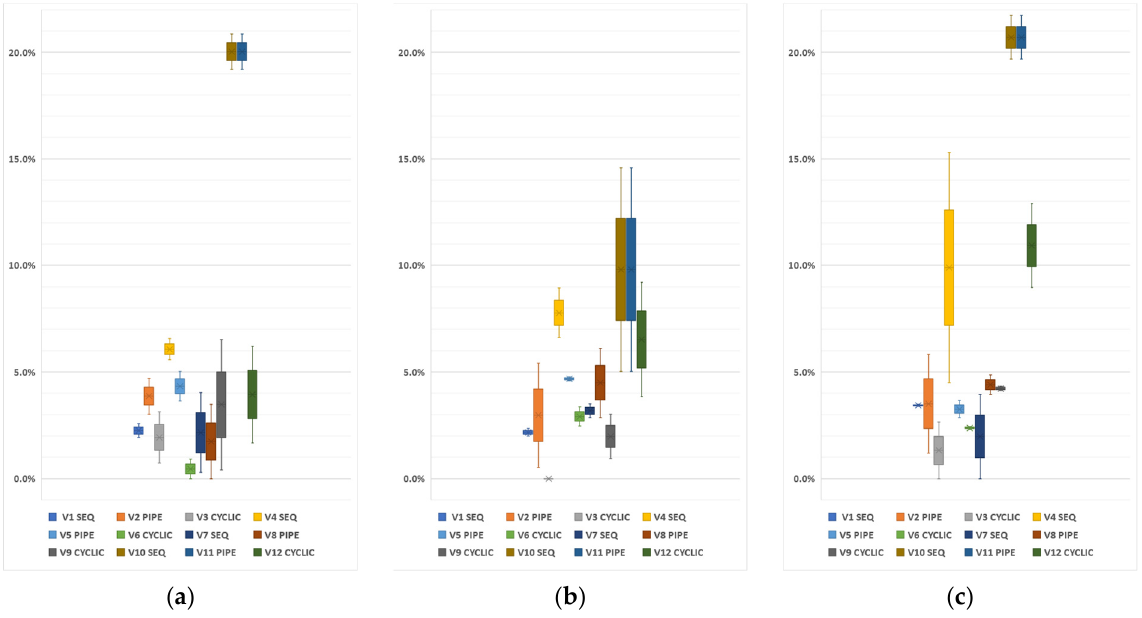
Figure 4. Gaps for ( a ) C, ( b ) R, and ( c ) RC instances.